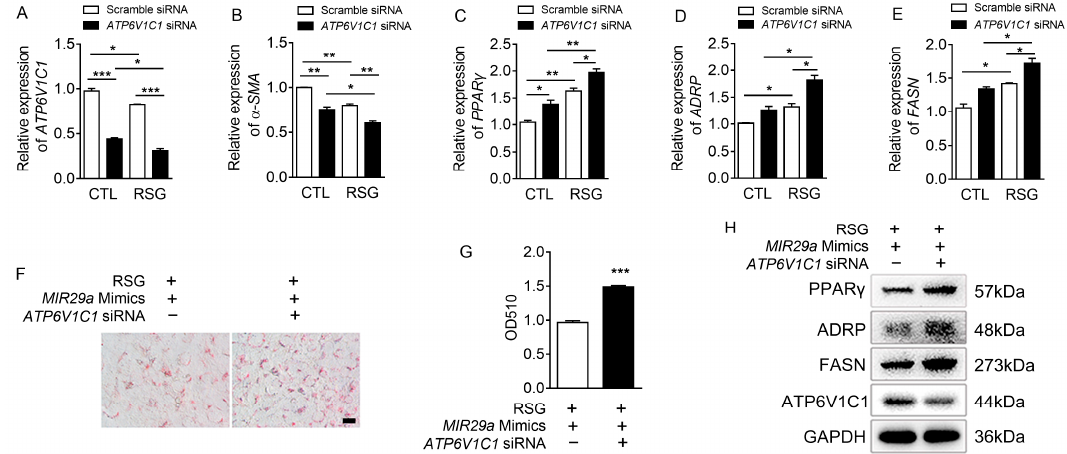
Figure 4. Knockdown of ATP6V1C1 attenuated the activation of LX-2 cells and up-regulated the expression of the adipogenic transcription factors. ( A – E ) ATP6V1C1 siRNA (60 nM) transfection was performed on LX-2 cells using Lipofectamine RNAimax. The gene expressions of ATP6V1C1 , α -SMA , PPAR γ , ADRP, and FASN mRNA were assessed by qRT-PCR ( n = 3 per group). ( F , G ) MIR29a mimics (100 nM) and ATP6V1C1 siRNA (60 nM) were transiently transfected into LX-2 cells for 24 h, and the cells were treated with RSG (5 μ M) for 24 h. Conventional Oil red O staining was conducted. After removing the staining solution, the dye retained in the cells was eluted into isopropanol, and OD510 was determined. Scale bar: 10 μ m. ( H ) Protein expression levels of PPAR γ , ADRP, FASN, and ATP6V1C1 in cell extracts were assessed by Western blot. GAPDH was used as a loading control. Throughout, the error bar represents SEM. * p < 0.05, ** p < 0.01, and *** p < 0.001.